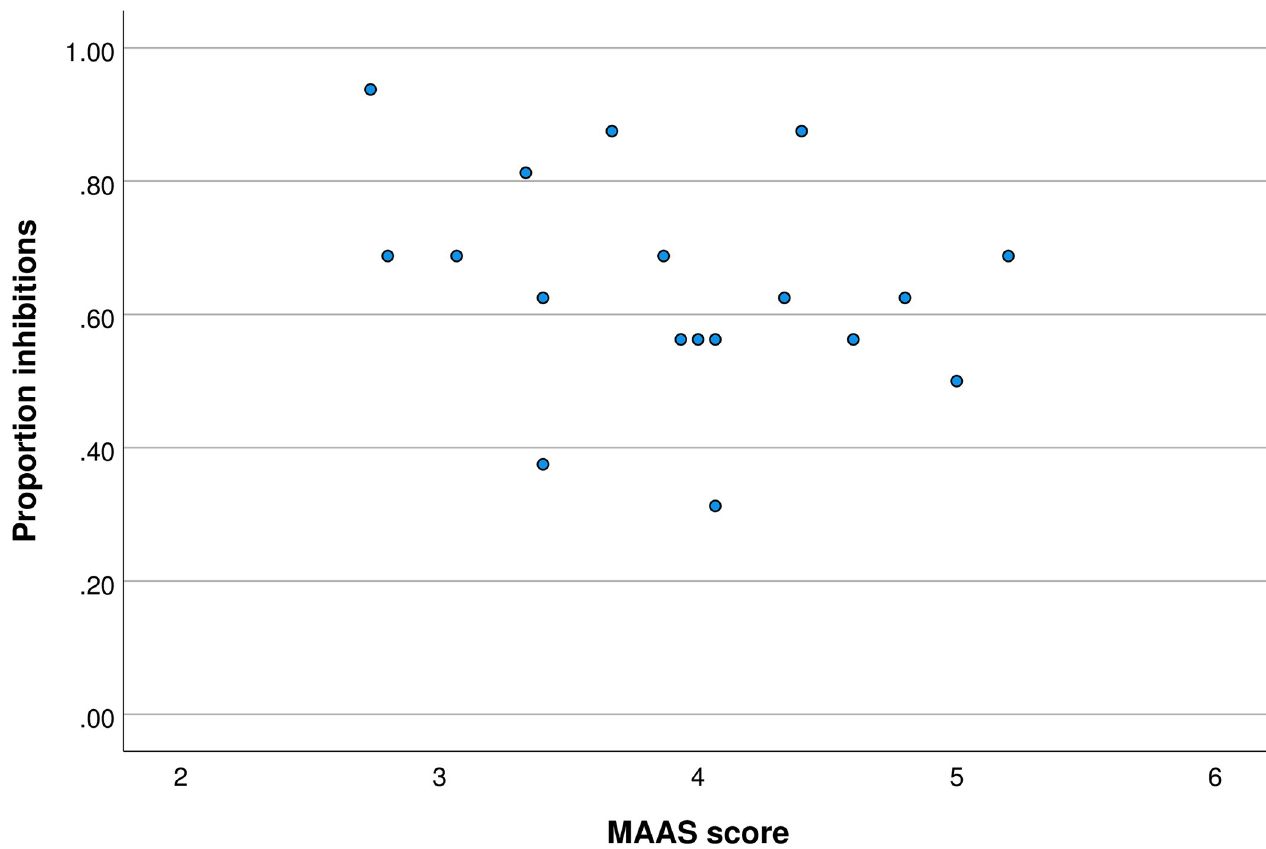
Fig 4. MAAS score and proportion inhibitions for faces viewed as no higher than moderately